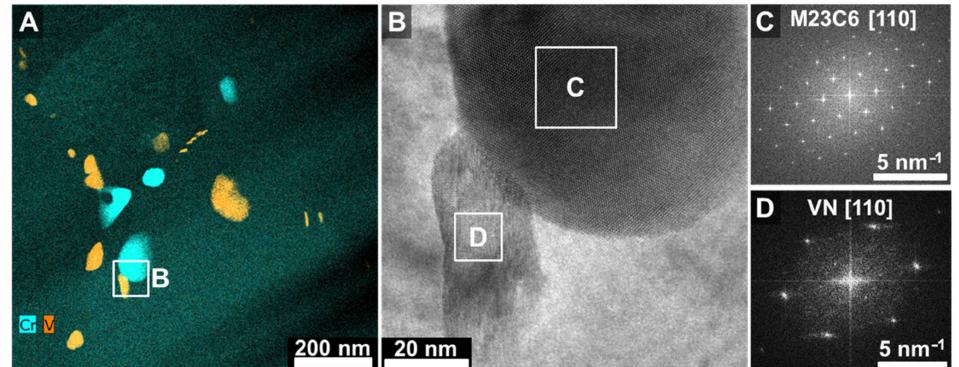
Figure 13. EDS map of Cr and V of HT-2 ( A ). HR TEM micrograph ( B ) of area B is shown with micrographs ( C , D ) displaying the FFT of the highlighted areas C and D. The corresponding EDS map ( A ) identifies V-rich regions as MX and Cr-rich regions as M 23 C 6